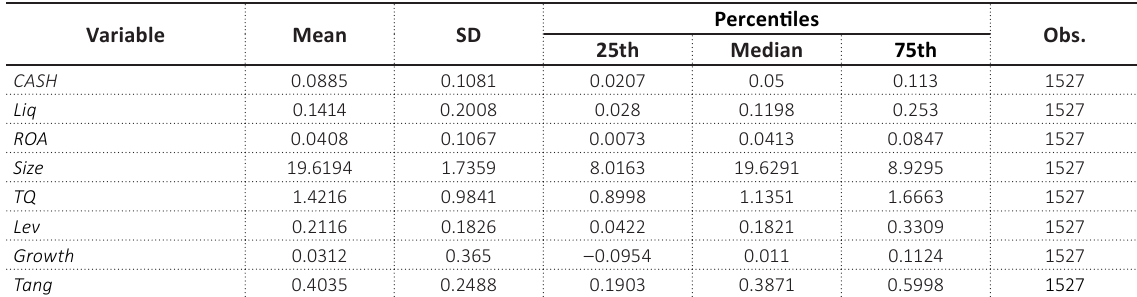
Table 1. Summary data